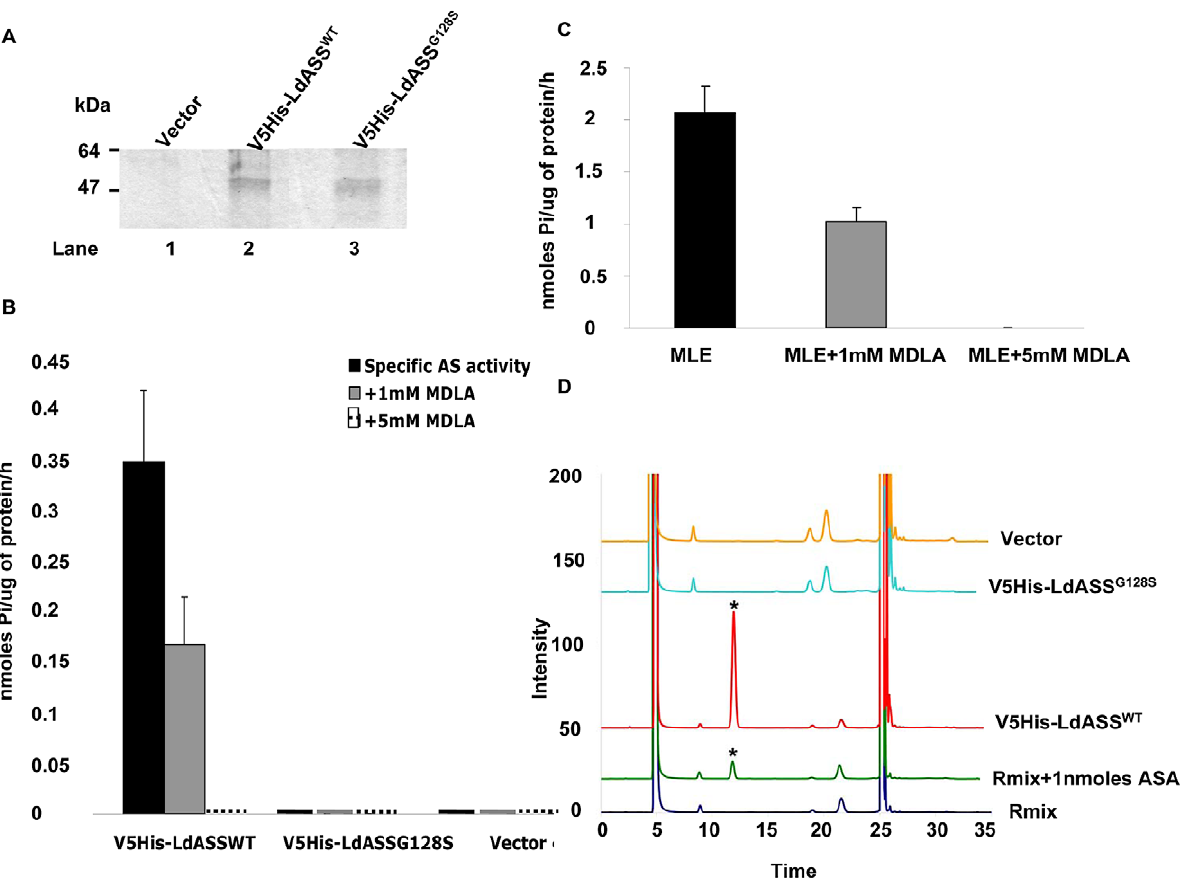
Figure 2. ASS activity assay. (A) Sample of recombinant ASS proteins affinity purified from 10 8 cells of vector control (lane 1), V5His-LdASS WT (lane 2) and V5His-LdASS G128S (lane 3) over expressing parasites using Ni-NTA resin beads, analyzed on an SDS gel and visualized with Gel code blue staining. (B) ASS activity measured by release of Pi in the presence of aspartate and citrulline substrates, obtained with Leishmania recombinant ASS proteins purified from the over expressing cell lines, in the absence (black bars), or presence of 1 mM (grey bars) or 5 mM of inhibitor (interrupted line). (C) Activity determined for Mouse Liver Extract (MLE) as a positive control for the assay. (D) HPLC analysis: Fluorescence intensity of OPA labeled components of ASS enzyme reaction. Overlay of elution profiles showing resolution of ASA (blue line: reaction mix, green line: 1 nmoles of ASA mixed with the reaction mix, red line: pulled down protein from V5His-LdASS WT cell line and incubated in presence of the reaction mix, turquoise line: pulled down protein from V5His-LdASS G128S cell line incubated in presence of the reaction mix, orange line: pull down from vector control incubated in presence of the reaction mix. The star indicates the ASA peak. The graphs shown are representative of 3 replicates of the assay.